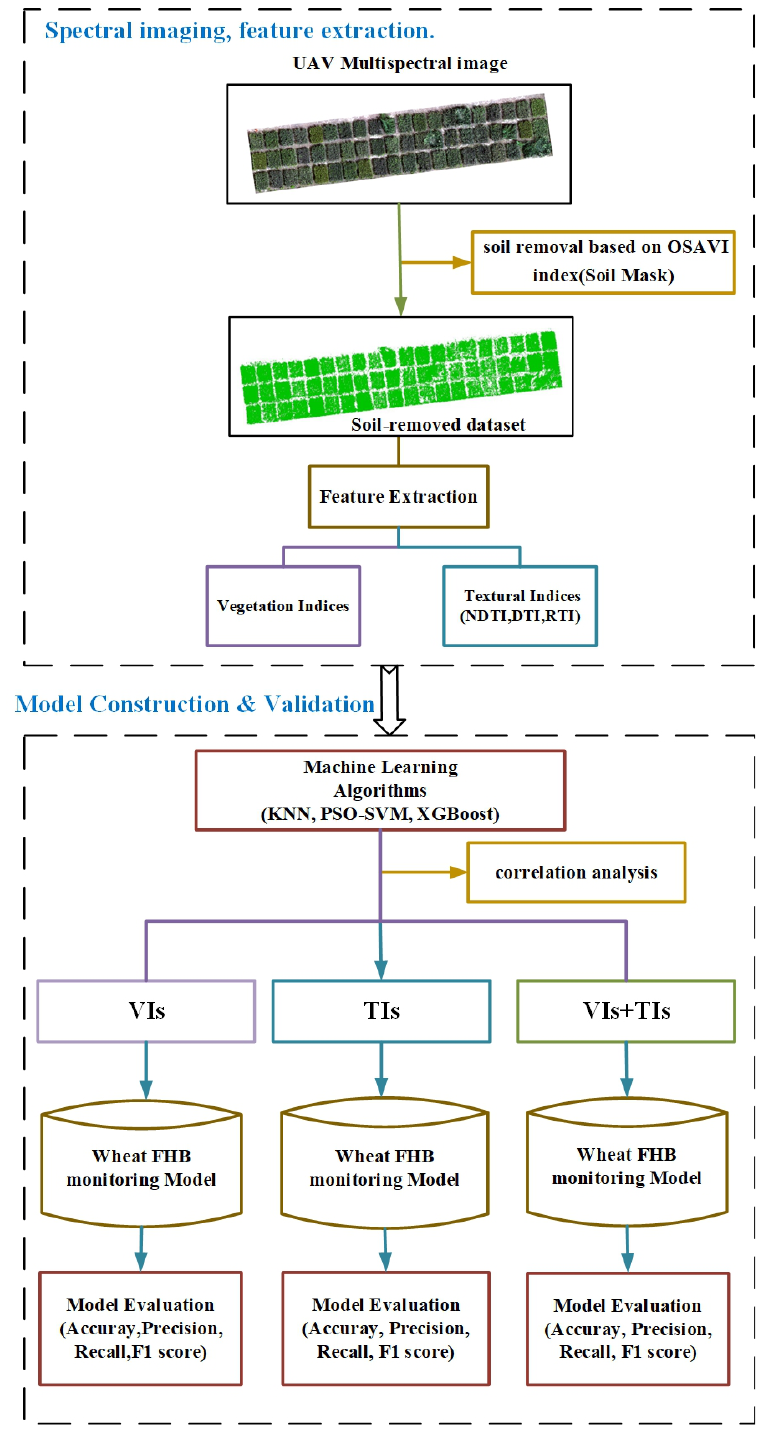
Figure 3. Workflow diagram for feature extraction and model construction and validation.